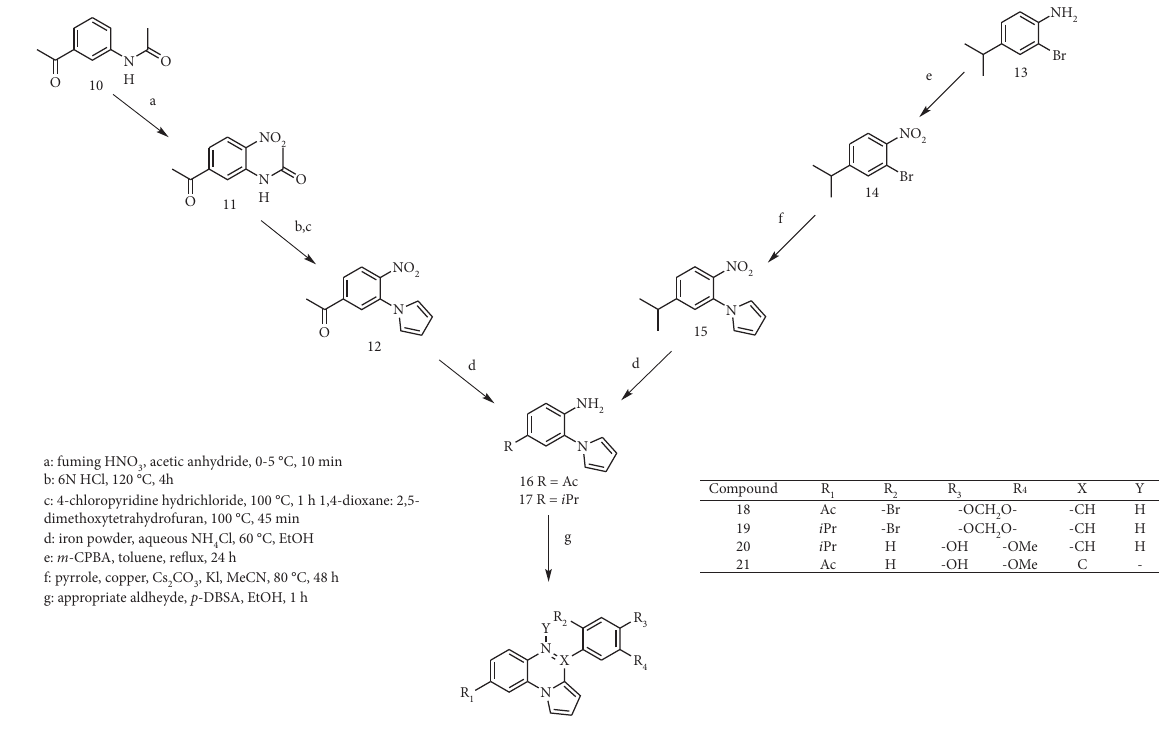
Figure 2: Synthesis of compounds